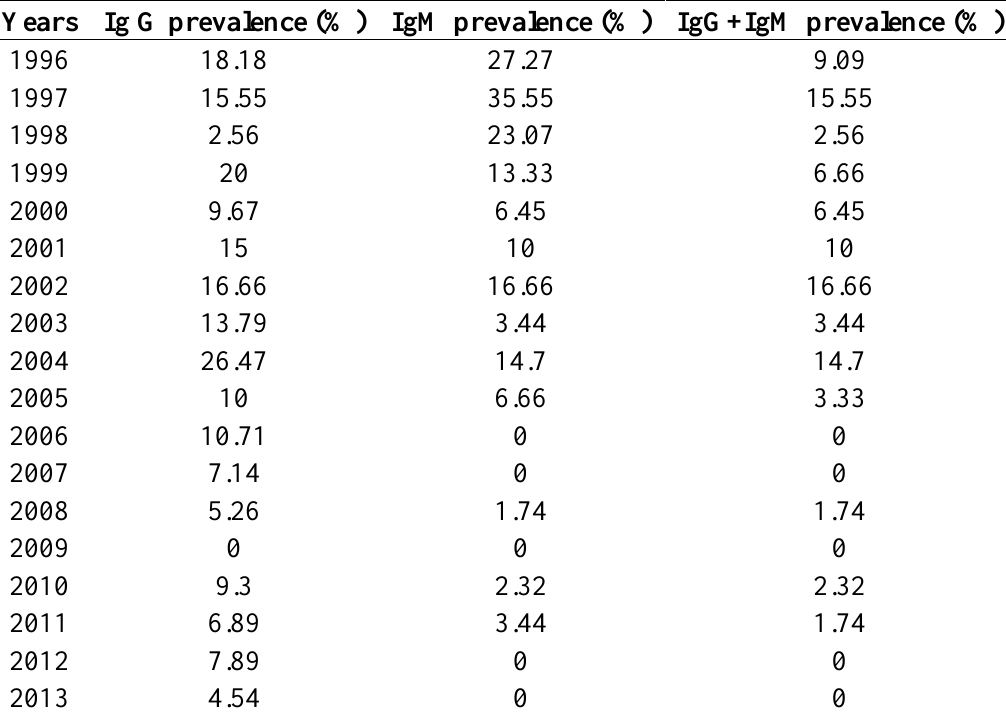
Table 3. Seroprevalence in relation to